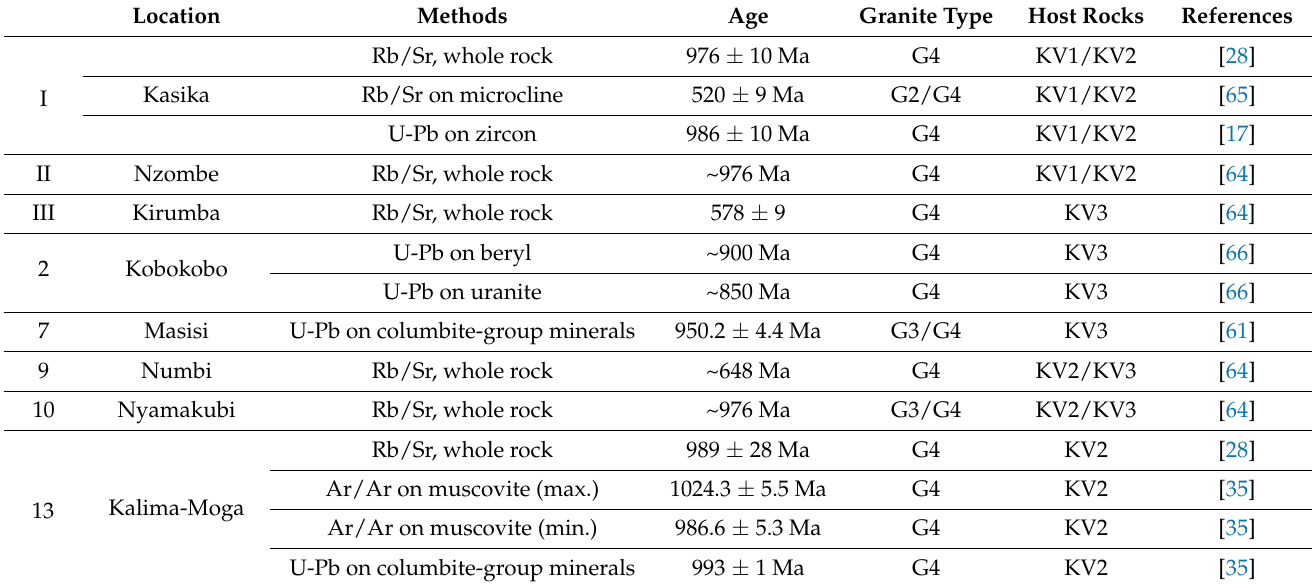
Table 1. Main geochronological age determination of the KVB granitic massifs. Locations of samples are in blue squares in Figure